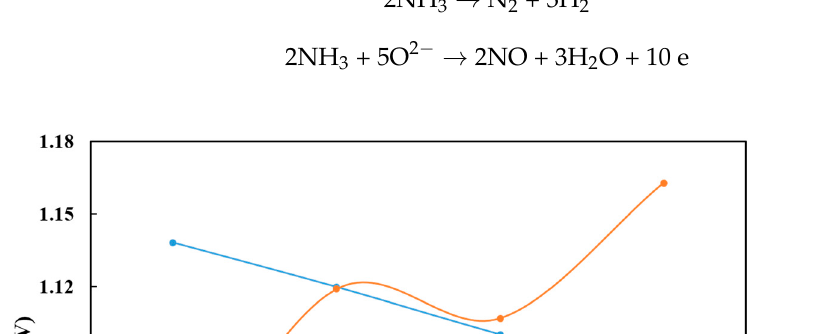
Figure 5. X-ray diffractograms collected from the Pd infiltrated Ag-LSCF anode surface before testing (LSCF PDF 04-019-6360, YSZ PDF 04-016-2113 and, Ag PDF 00-004-0783).